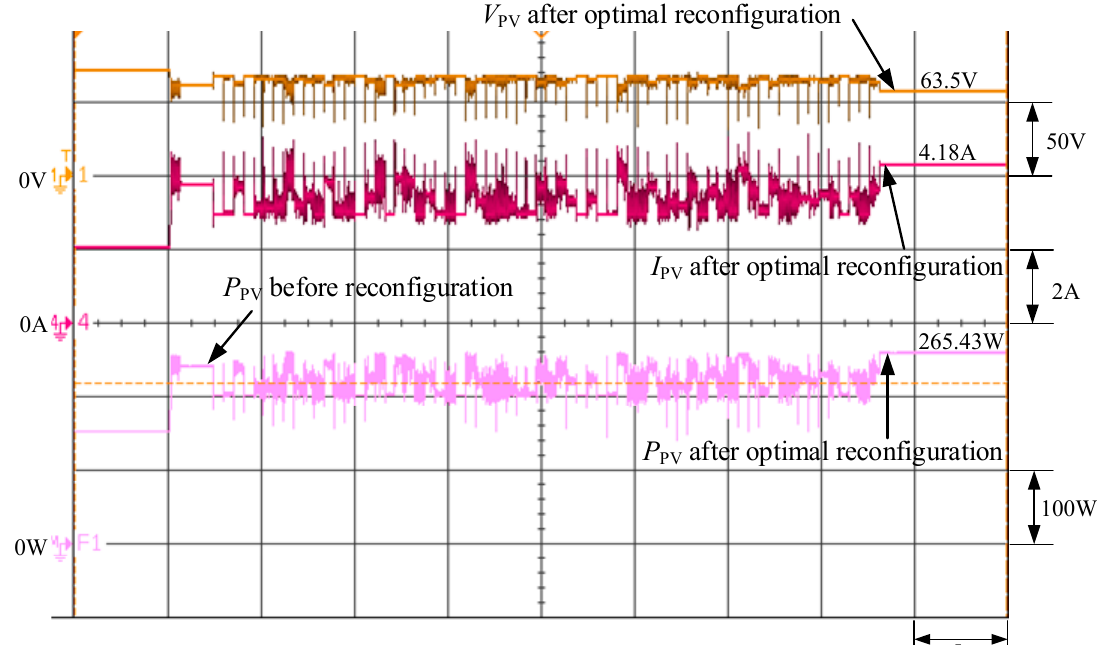
Figure 15. Response to an optimization request in a Case 4 array